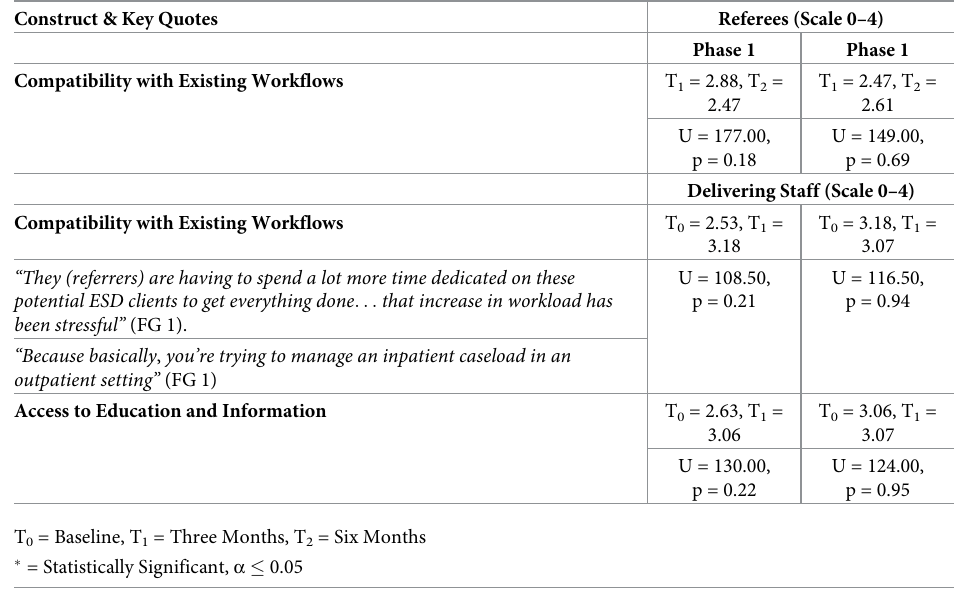
Table 4. Findings for Inner setting